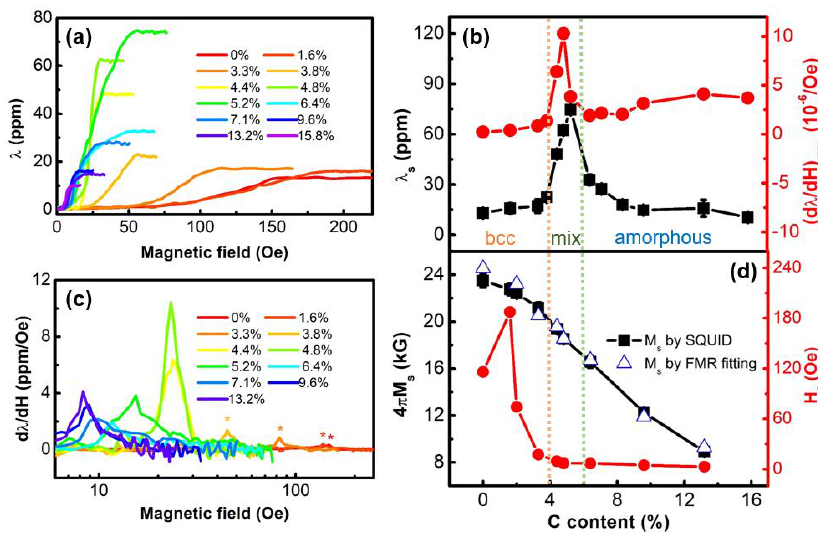
Figure 13. ( a ) Magnetostriction constant of (Co 0.5 Fe 0.5 ) x C 1−x films with x=0 to 15.8%. ( b ) The saturated magnetostriction constant (black) and piezomagnetic coefficient (red) with different carbon content. The structural boundaries of the alloy are marked with light orange and green dotted lines. ( c ) Piezomagnetic coefficient versus corresponding driving magnetic field for (Co 0.5 Fe 0.5 ) x C 1−x films with x=0 to 13.2%. ( d ) The M s (black) and H c (red) versus carbon content. The blue open triangles are the fitted M s from broadband FMR measurement. Reproduced with permission from [112]. Copyright [2019], American Physical Society.